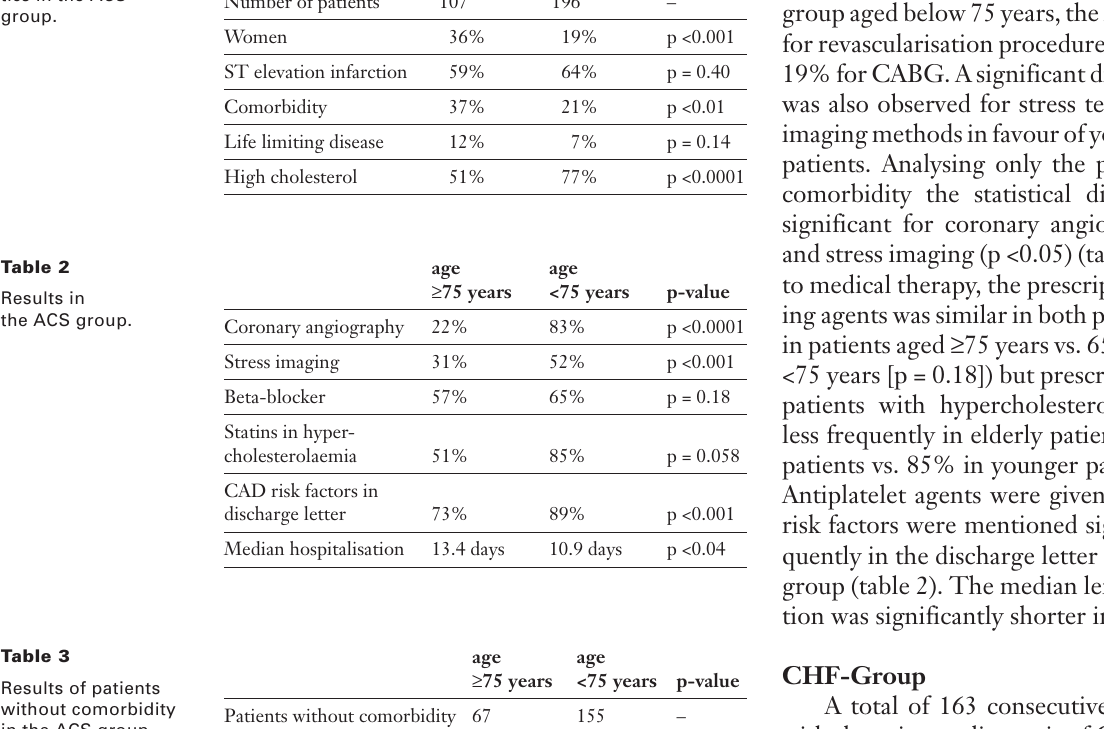
Patient characteris- tics in the ACS group.